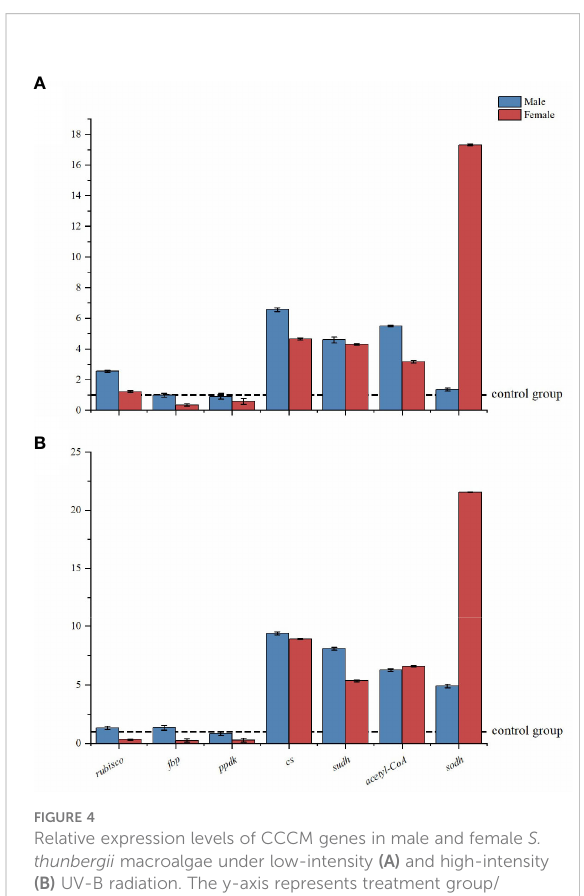
FIGURE 4 Relative expression levels of CCCM genes in male and female S. thunbergii macroalgae under low-intensity (A) and high-intensity (B) UV-B radiation. The y-axis represents treatment group/ control group fold changes. The control group gene expression was set at